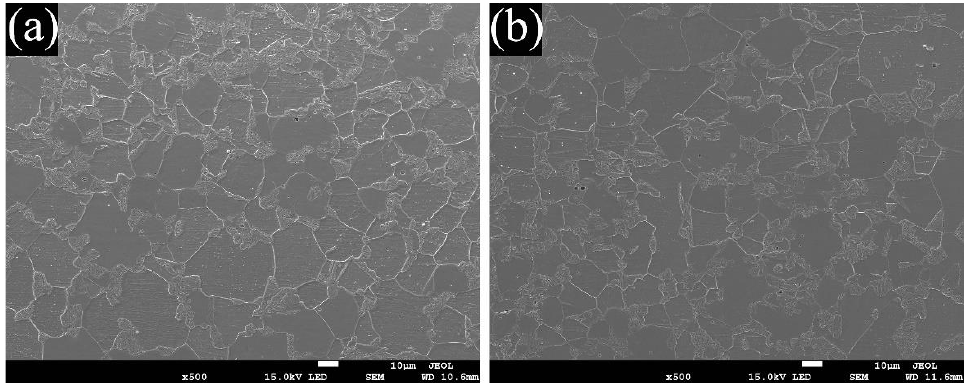
Figure 11. SEM images of the fine-grain zone in the HAZ: ( a ) without ultrasonic treatment and ( b ) with ultrasonic treatment.